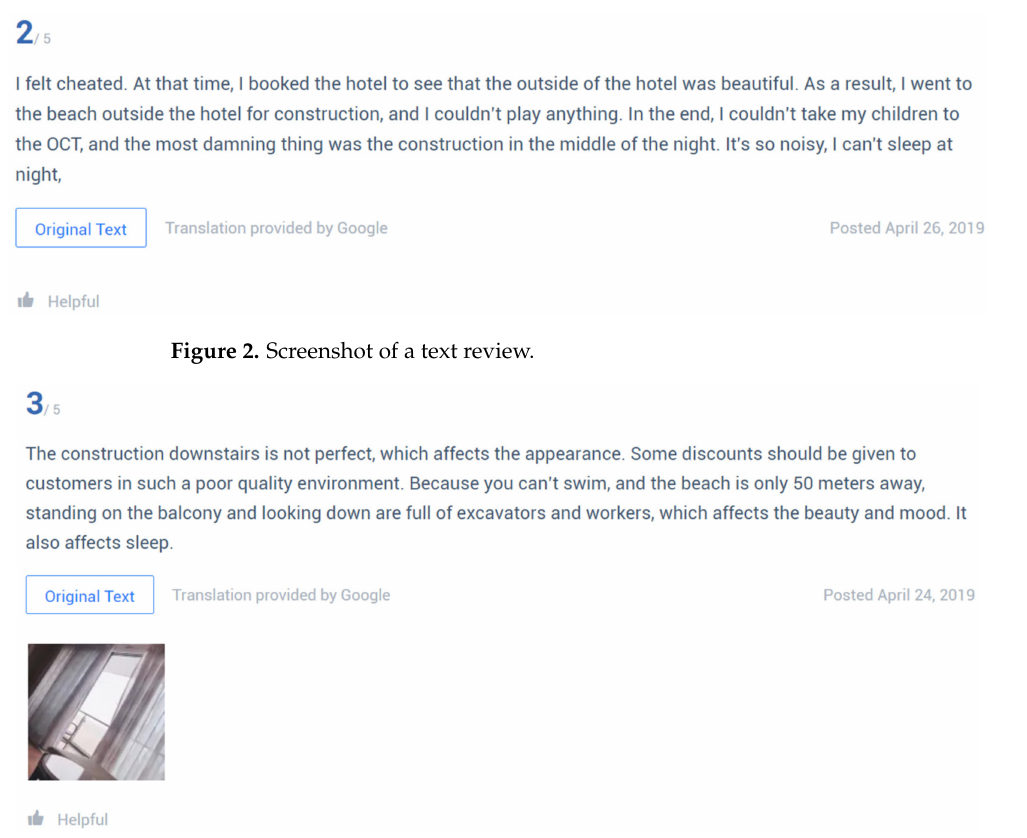
Figure 3. Screenshot of a picture